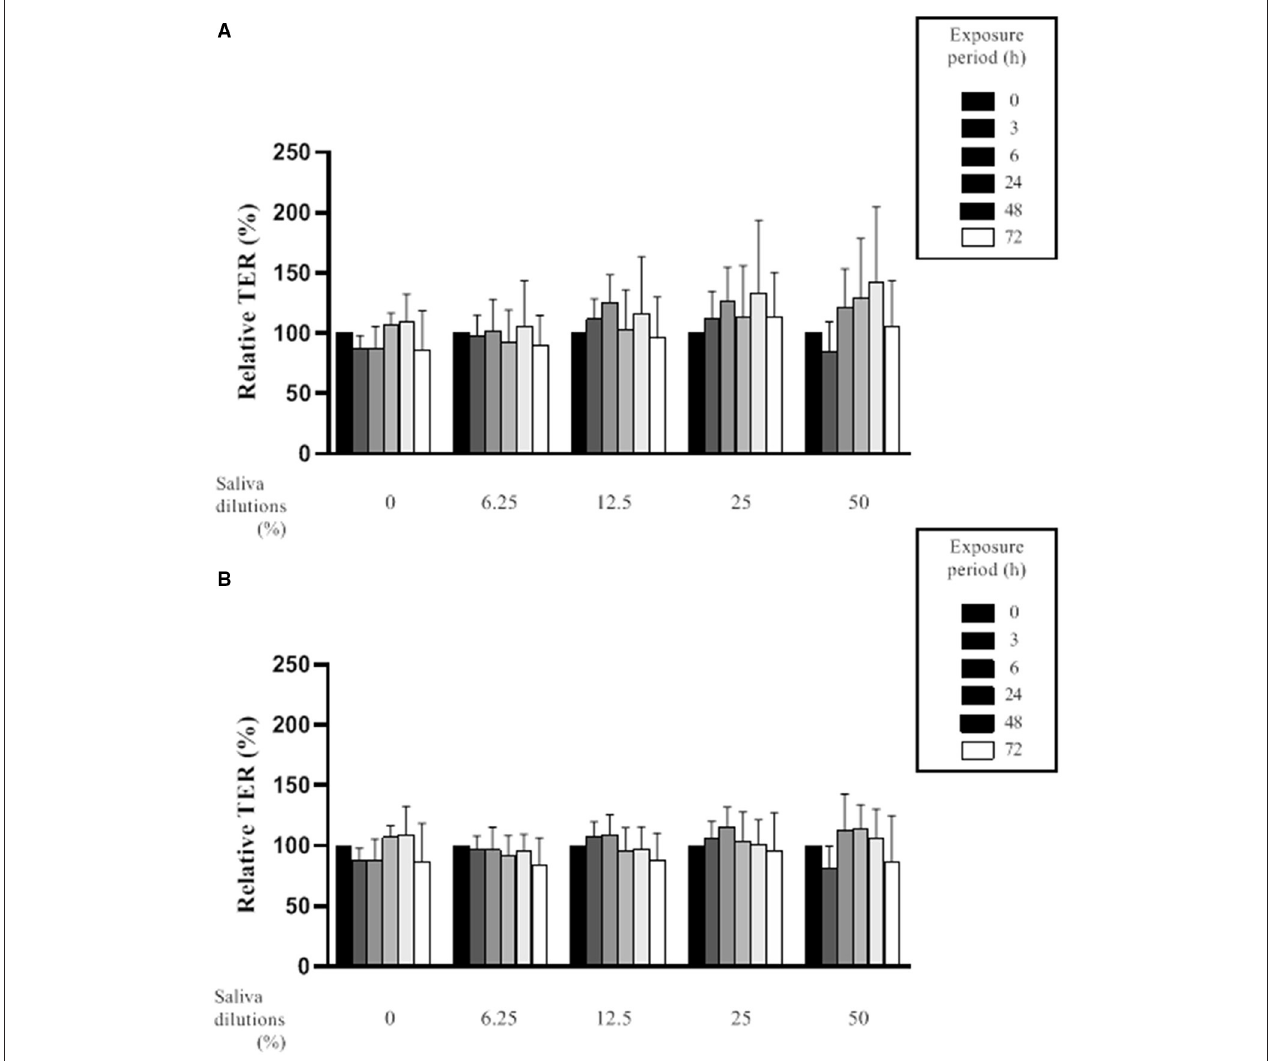
FIGURE 2 | Effect of various dilutions of filter-sterilized saliva from periodontitis subjects (A) and healthy subjects (B) on the relative transepithelial electrical resistance (TER) of an epithelial barrier model following different exposure periods. Data are expressed by group (periodontitis and healthy) as the mean ± SD of the relative TER determined in triplicate assays. No significant differences ( p < 0.05) were observed between the periodontitis and healthy subjects at any saliva dilution or time